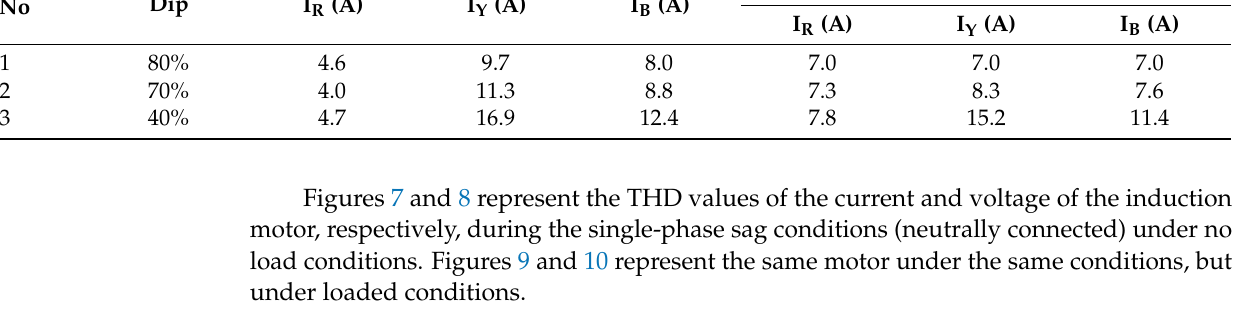
Figure 8. Voltage THD of induction motor under no load conditions [neutral connected]. Figure 9. Current THD of induction motor under loaded conditions [neutral connected].